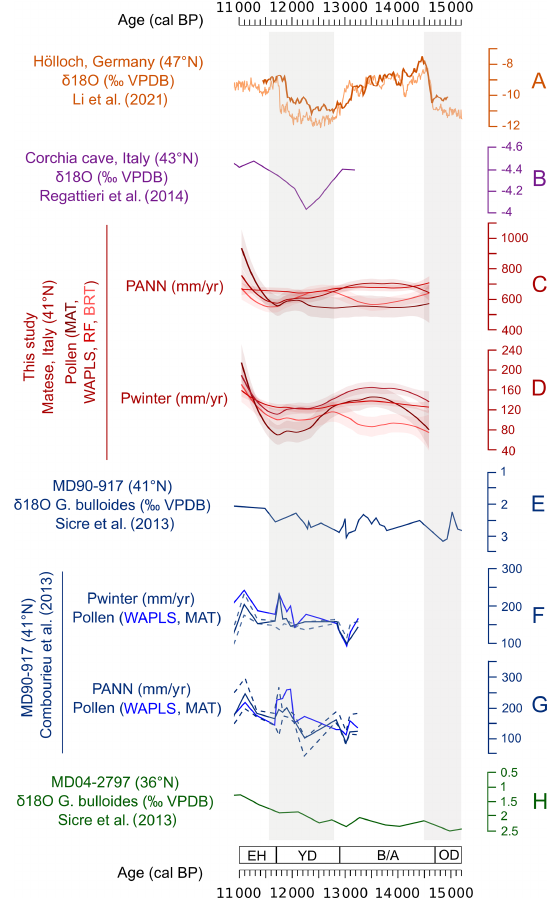
Figure 10. Synthesis of precipitation records inferred from dif- ferent proxies in Italy from 15000 to 11000calBP. PANN stands for mean annual precipitation. P winter is winter precipitation. OD stands for Oldest Dryas. B/A stands for Bølling–Allerød. YD stands for Younger Dryas. EH stands for early